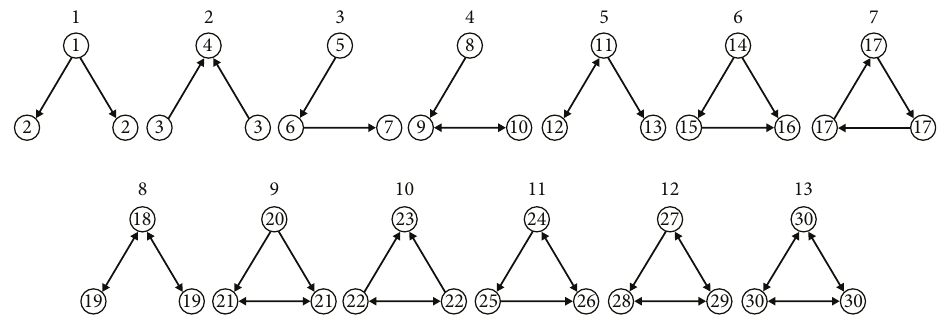
Figure 1: All 13 types of interaction triads with 30 characteristic